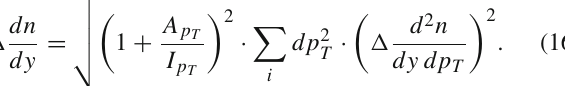
The p T -integrated and extrapolated dn K ∗ ( 892 ) 0 mesons is plotted in Fig. 12 and the numerical values are listed in Table